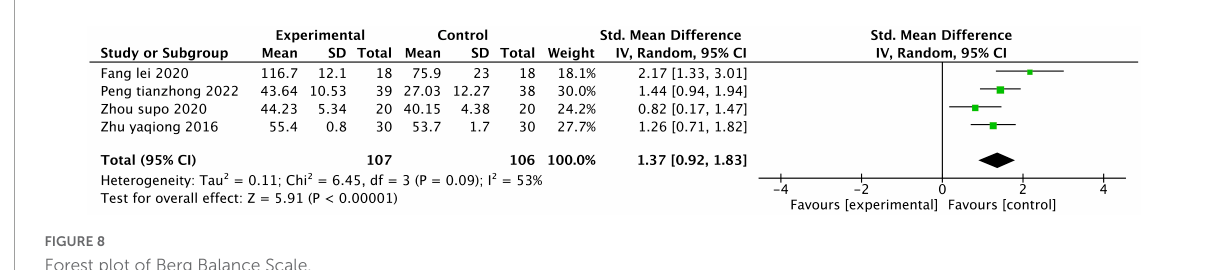
FIGURE8 Forest plot of Berg Balance